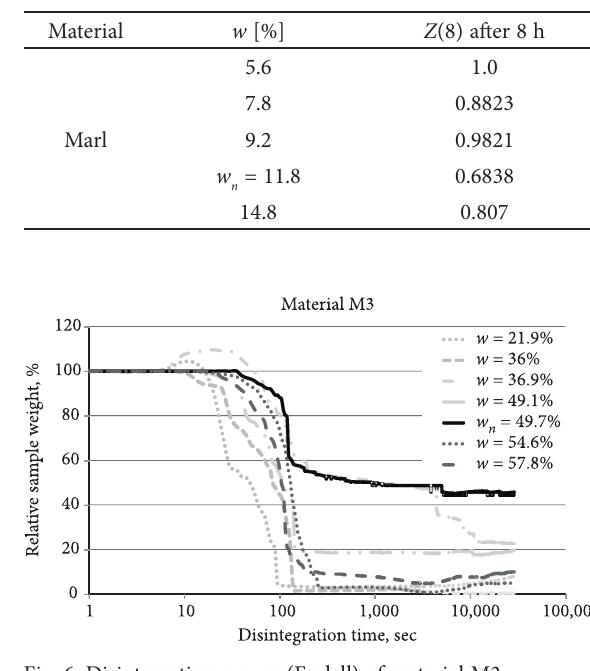
Fig. 6. Disintegration curves (Endell) of material M3